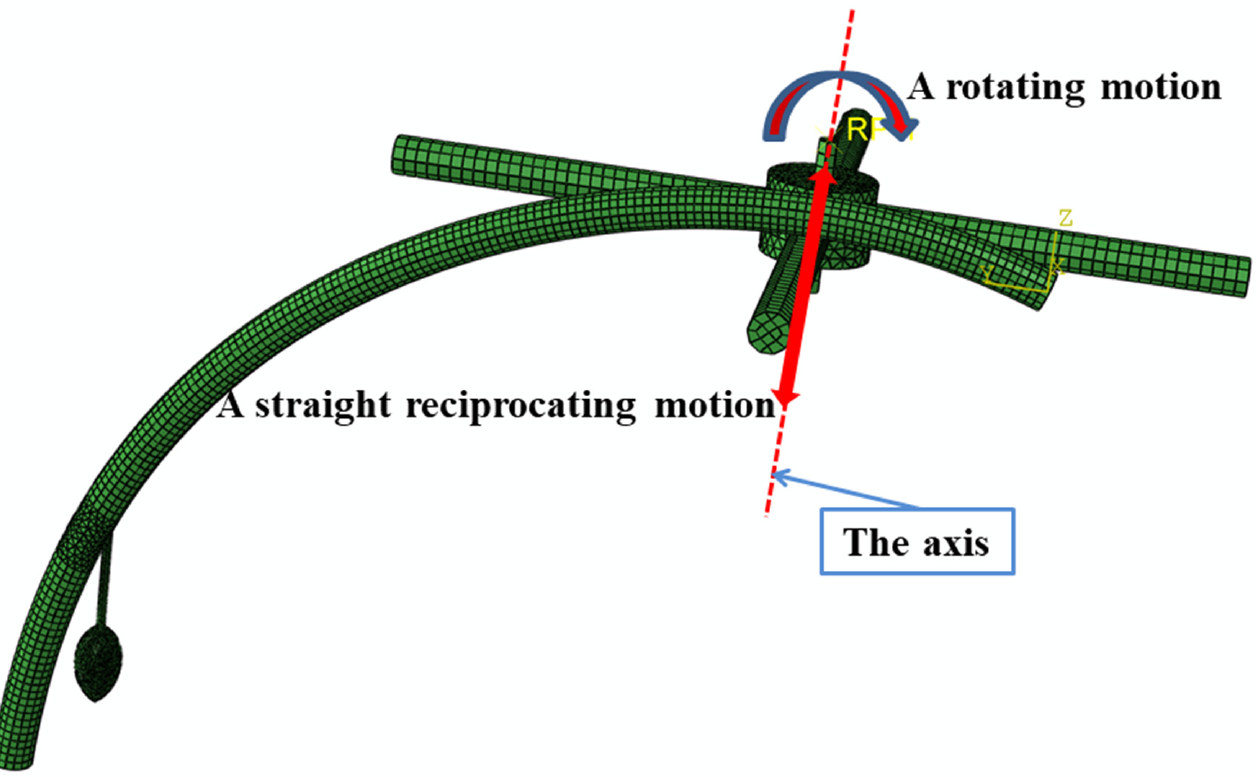
Figure 1. The meshed 3D models.